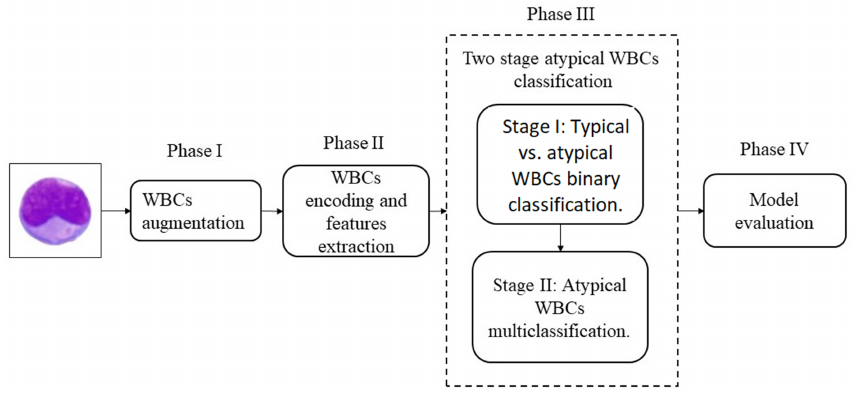
Figure 2. Components of the two-stage DCAE-CNN atypical WBC classification